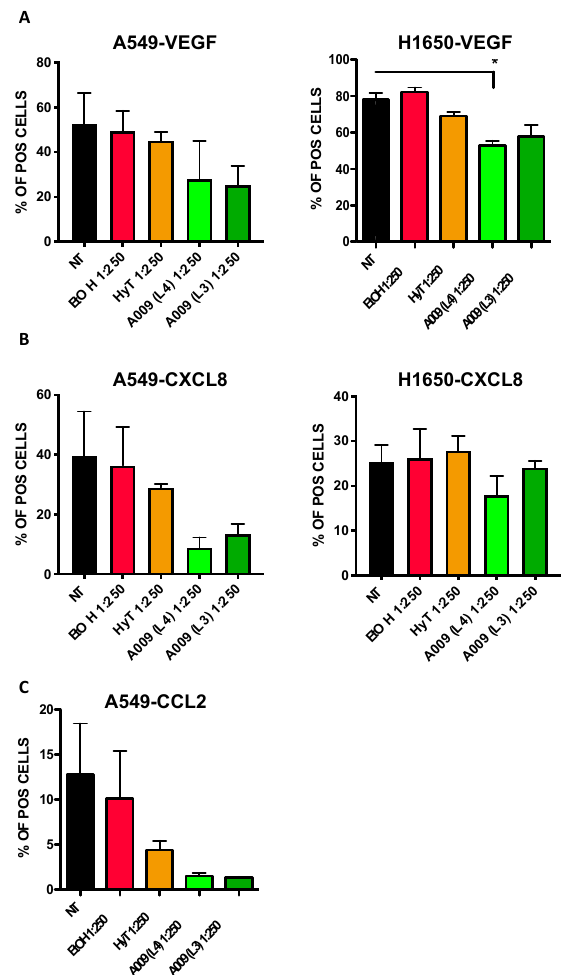
Figure 6. E ff ect of the A009 extracts on the production of pro-angiogenic factors in lung cancer cells in vitro. The A549 and H1650 lung cancer cells were treated for 6 h with 2 di ff erent batches of A009 (L4 and L3), at the dilutions 1; 500, 1: 250 or with hydroxytytosol (HyT) at the same concentration present in the dilutions of A009. Protein secretion was stimulated with a cocktail containing BrefeldinA and Monensin + Ionomycin and Forbol-12-meristate, 13-acetate. After 6 h of stimulation, analyzed for VEGF ( A ), CXCL8 ( B ) and CCL2 (C) production, by flow cytometry. Flow data were analyzed using FlowLogic software. Results are shown as mean ± SEM, One Way ANOVA, * p < 0.5. NT (untreated); EtOH (ethanol vehicle used to dissolve hydroxytyrosol).